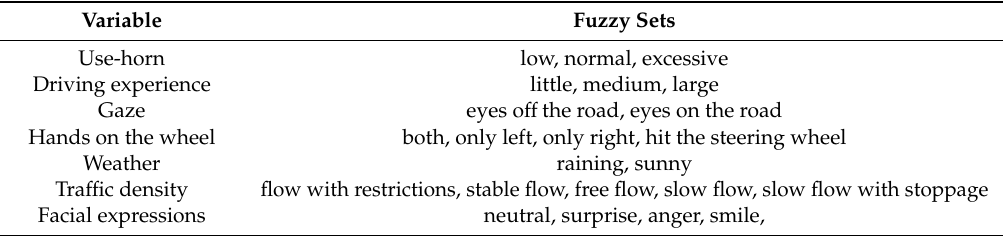
Table 8. Description of some of the input fuzzy variables.